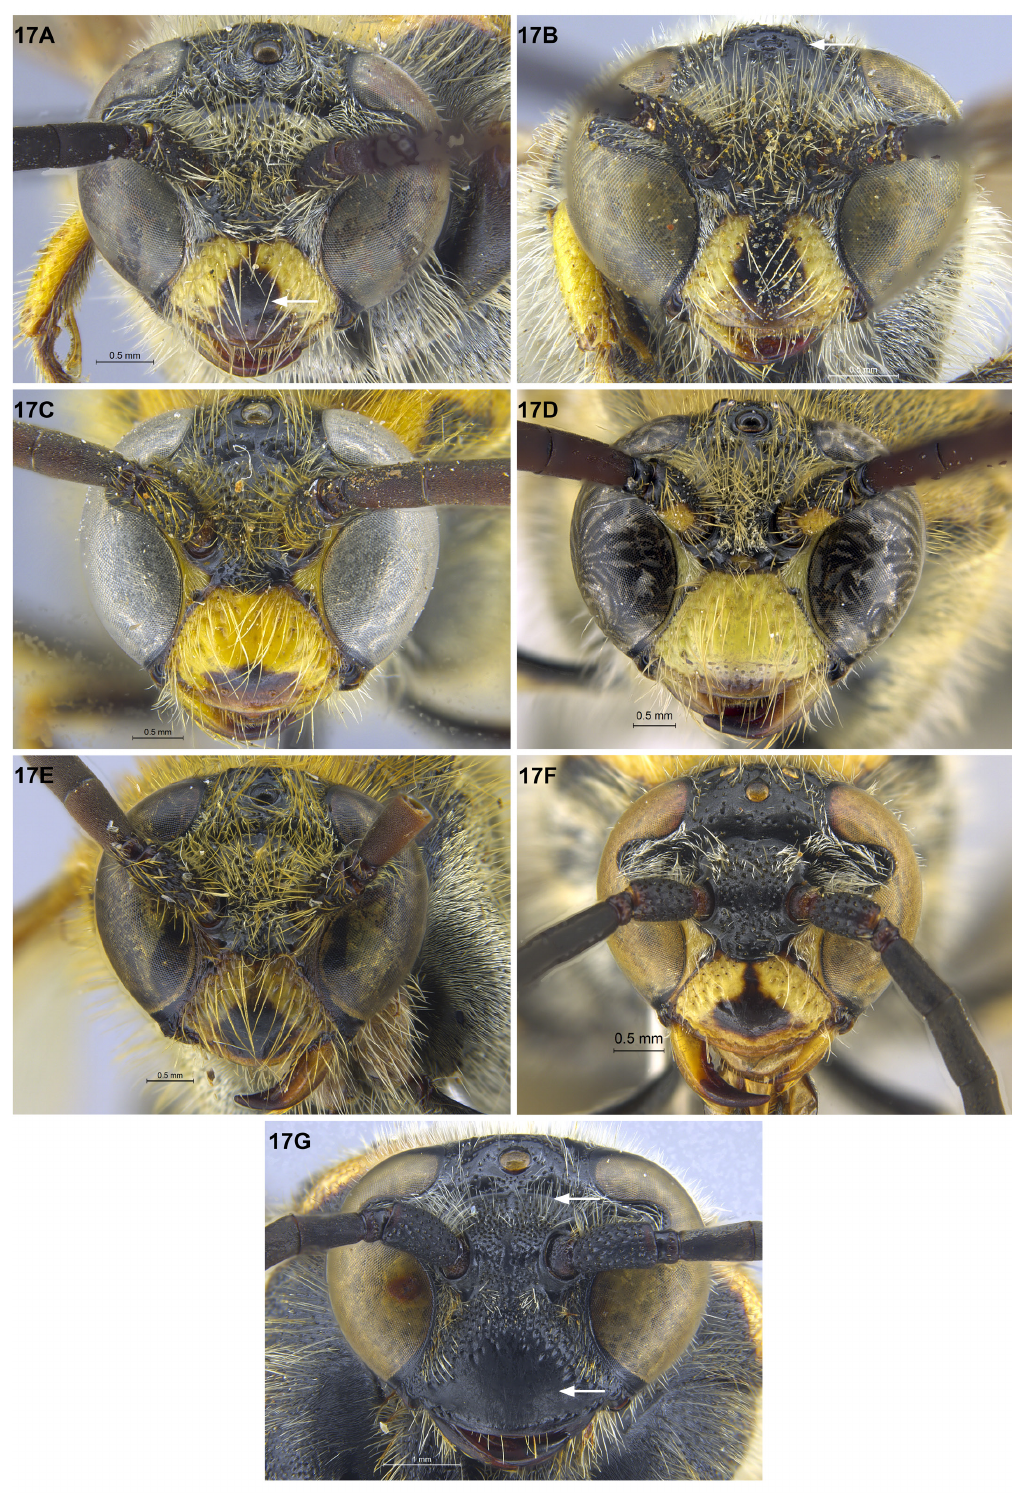
Fig. 17. Males, face. A . Campsomeriella annulata annulata (Fabricius, 1793). B . Camps. collaris (Fabricius, 1775). C . Megacampsomeris sp. 1. D . Megacam. formosensis chinensis Betrem, 1941. E . Megacam. prismatica (Smith, 1855). F . Phalerimeris phalerata phalerata (de Saussure, 1858). G . Sericocampsomeris flavomaculata Gupta & Jonathan,